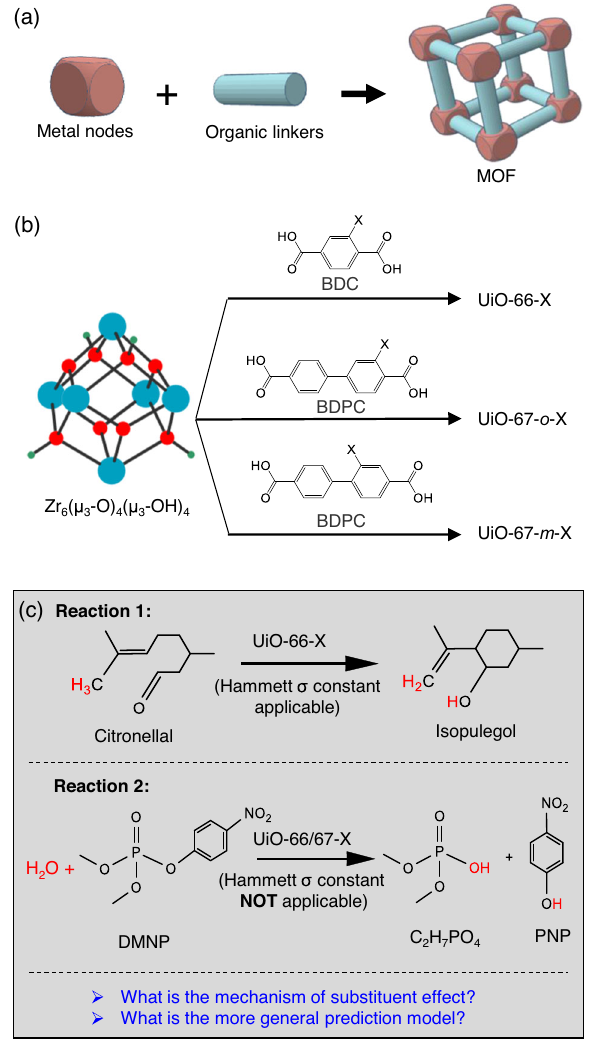
Fig. 1 Metal-organic frameworks (MOFs) and reactions catalyzed by them. a Construction of a MOF structure with the metal nodes and organic linkers; b Construction of the UiO-66-X, UiO-67- o -X, and UiO-67- m -X MOFs, in which X-substituted benzene-1,4-dicarboxylic acid (BDC) and biphenyl-4,4 ′ -dicarboxylic acid (BPDC) are the linkers. c Reactions 1 and 2 catalyzed by the MOFs and the questions to be studied in this work. In c , the atoms closely relevant to the reactions are shown in red. The color setting for atoms in b : Zr, gray blue; H, green; O, red; C, gray.